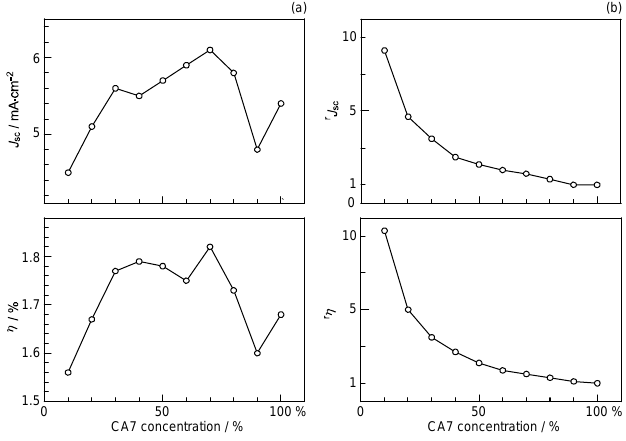
Figure 13. Effects of dilution of the CA7 sensitizer with a spacer, deoxycholic acid